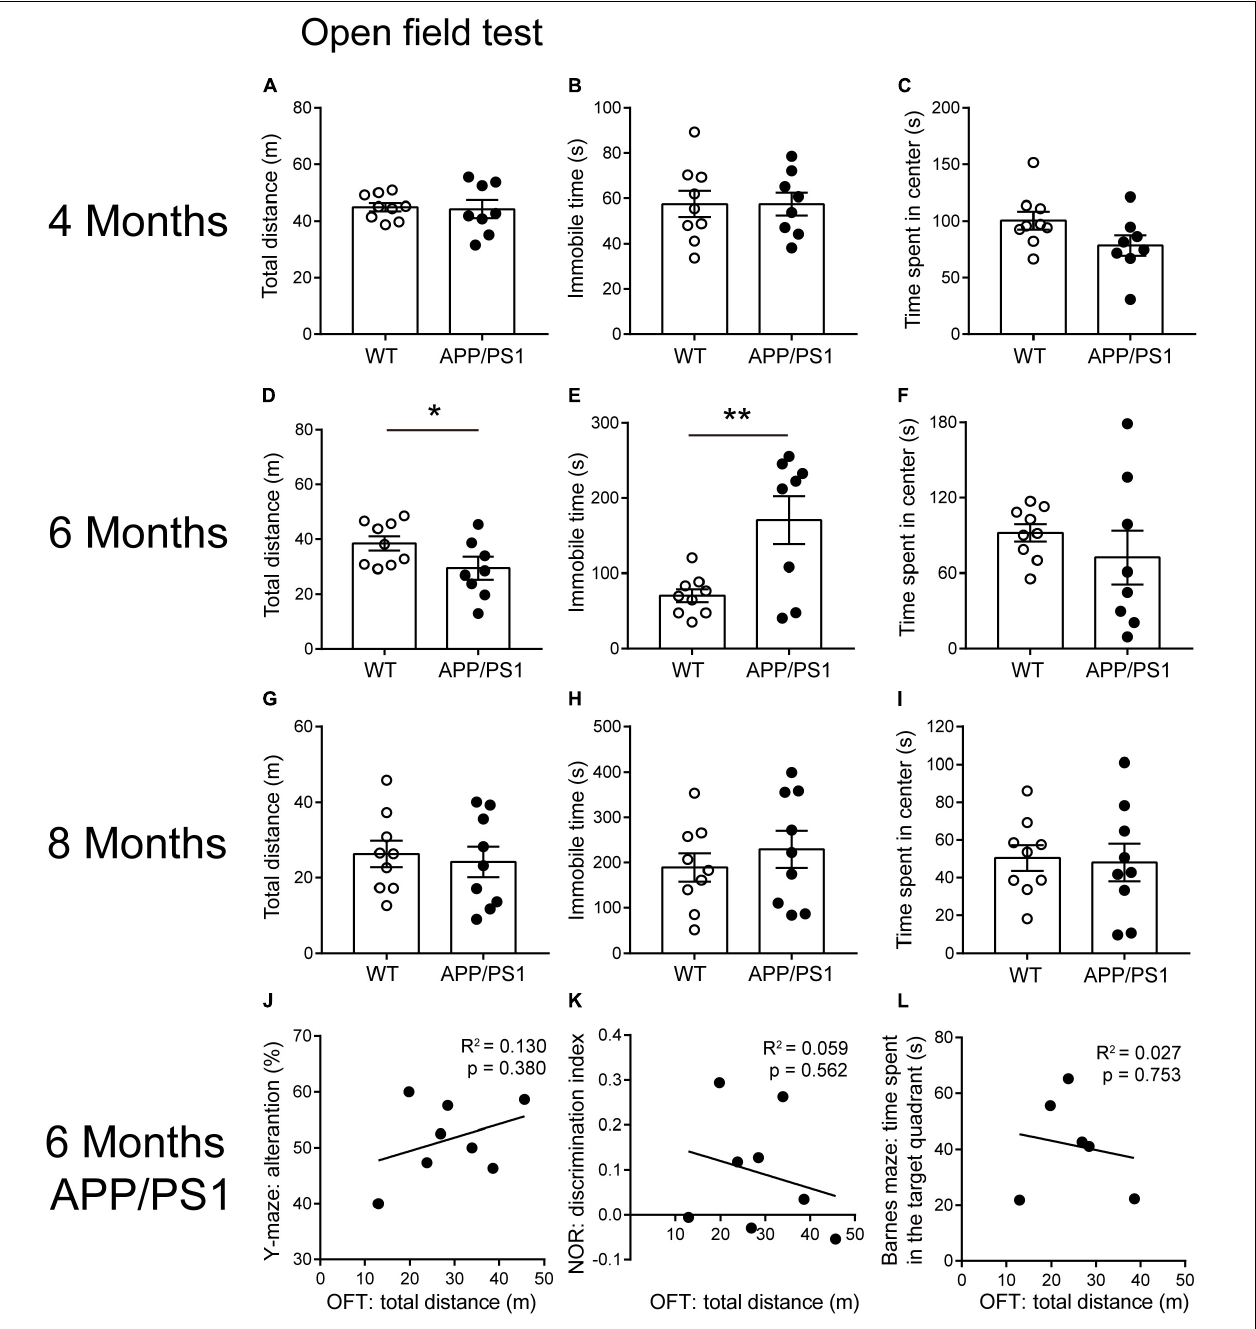
FIGURE 3 | Open field test performance for 4-, 6-, and 8-month-old WT and APP/PS1 mice ( n = 8–9/group). (A–C) In 4-month-old WT and APP/PS1 mice, no statistically significant differences were observed in the indicators (total distance, time spent in the center, and immobile time) of OFT. (D–F) In 6-month-old mice, APP/PS1 mice showed reduced total distance (* p < 0.05, unpaired t -test) and increased immobile time (** p < 0.001, unpaired t -test) in OFT, compared with WT mice, but there was no difference in the time spent in the center. (G–I) In 8-month-old mice, there were no differences in these indicators of OFT. (J–L) There was no significant correlation between the total distance in OFTs and the performance in Y-maze, NOR, or Barnes maze in 6-month-old APP/PS1 mice. Each point on these graphs represents an independent mouse.